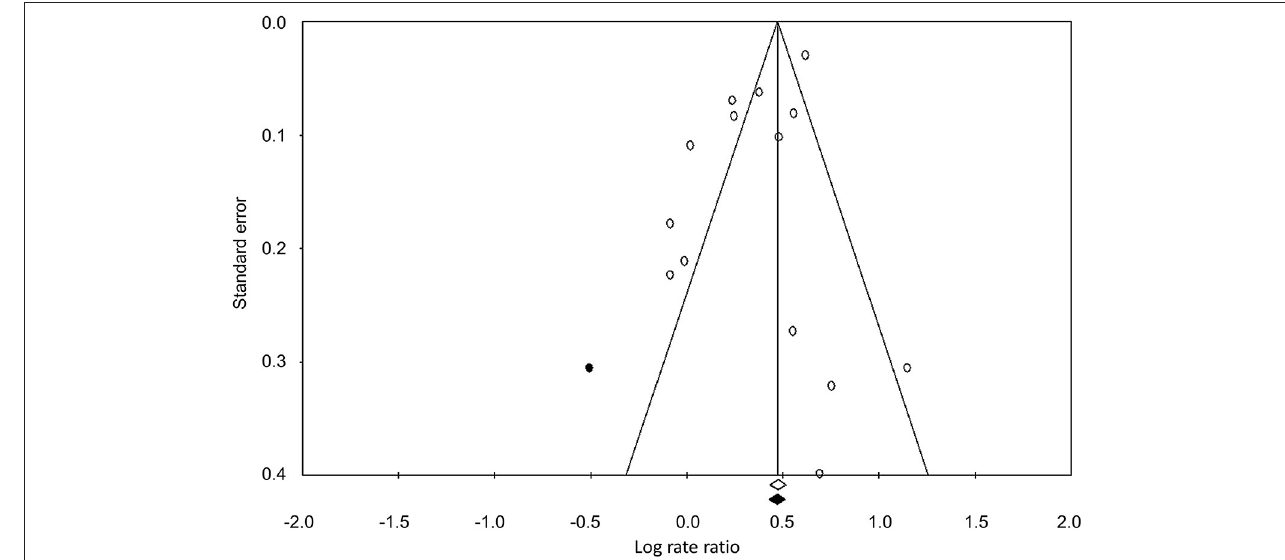
FIGURE 2 | The publication bias by the Duval and Tweedy’s trim and fill method.